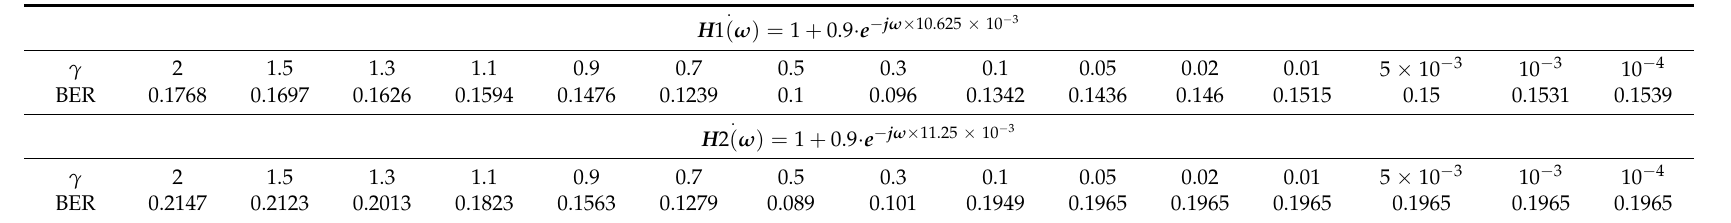
Table 1. BER values for FM-OFDM-QPSK depending on the saturation parameter γ